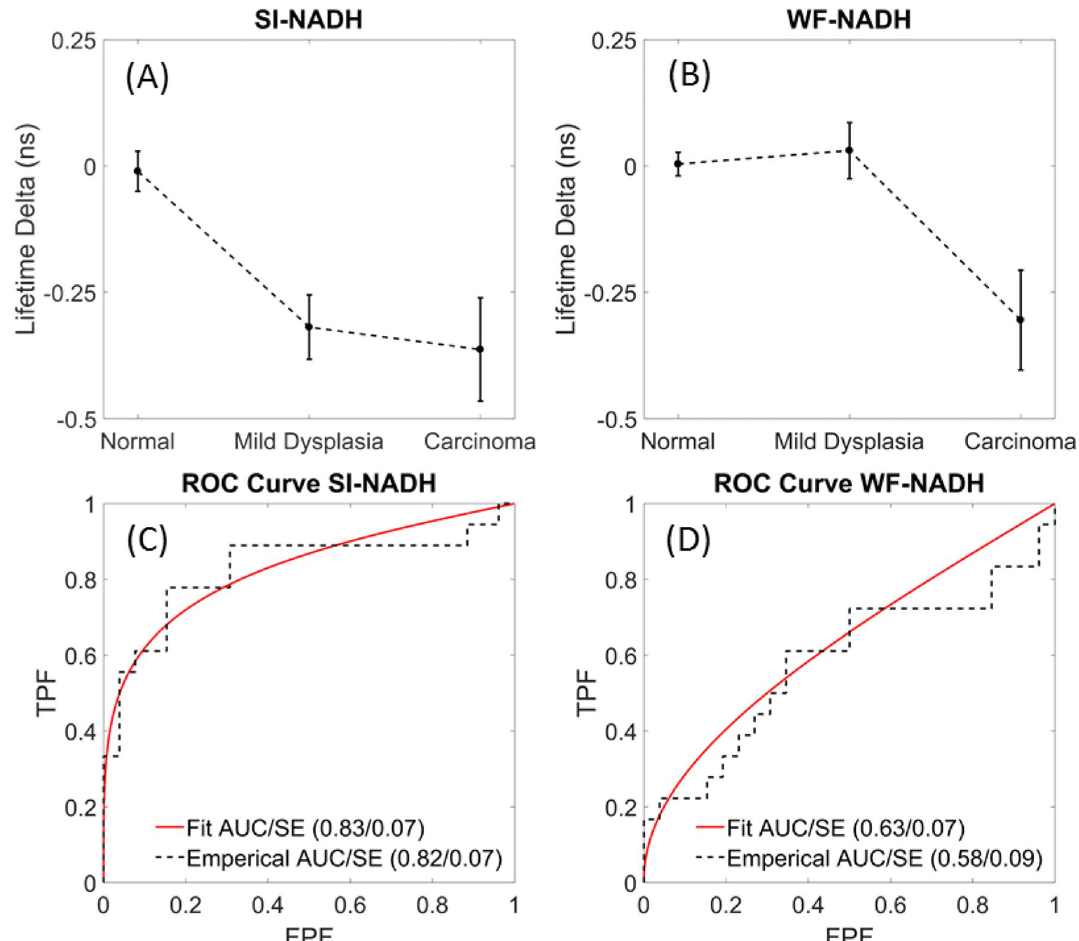
Figure 4. Trend in lifetime deltas of the ( A ) SI-NADH and ( B ) WF-NADH channels for normal, mild dysplasia, and carcinoma. Data points are of the mean lifetime delta and error bars are ± one standard error. ROC curves compare the differentiating power of ( C ) SI-NADH and ( D ) WF-NADH for cases of mild dysplasia against normal. The fitted curves were made using a proper binormal